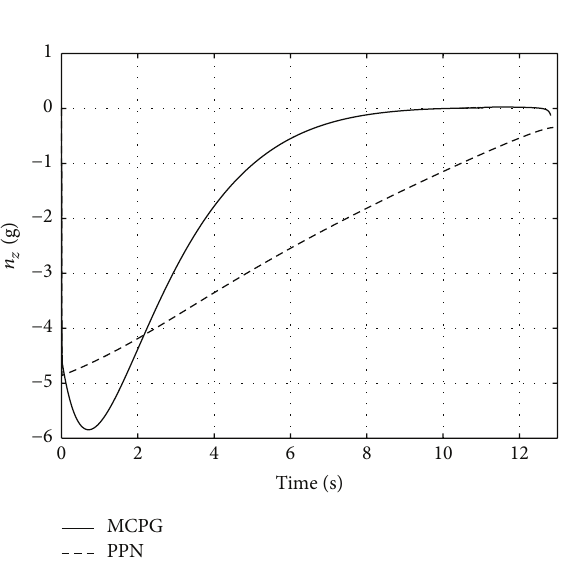
Figure 9: LOS angular velocity of missile.